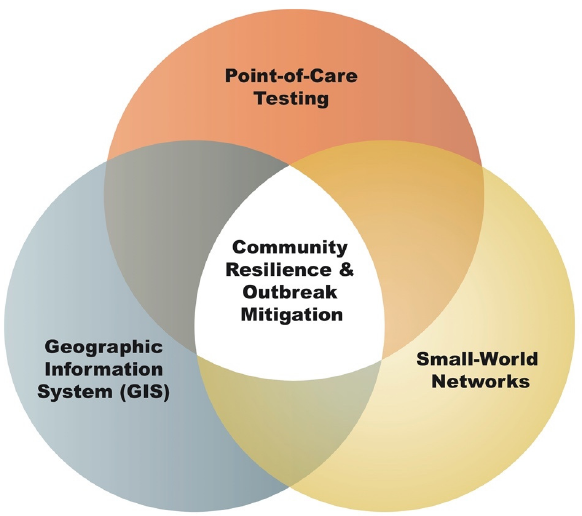
Figure 5. Dynamic model to enhance community diagnostic capabilities . Community resilience can be enhanced through the dynamic relationship between GIS, SWN, and POCT. GIS plays an important role in identifying geospatial relationships between health resources in SWNs. By optimally incorporating POCT in SWN, vulnerable health resource facilities may obtain diagnostic medical information that drives clinical decision making upstream of SCP.